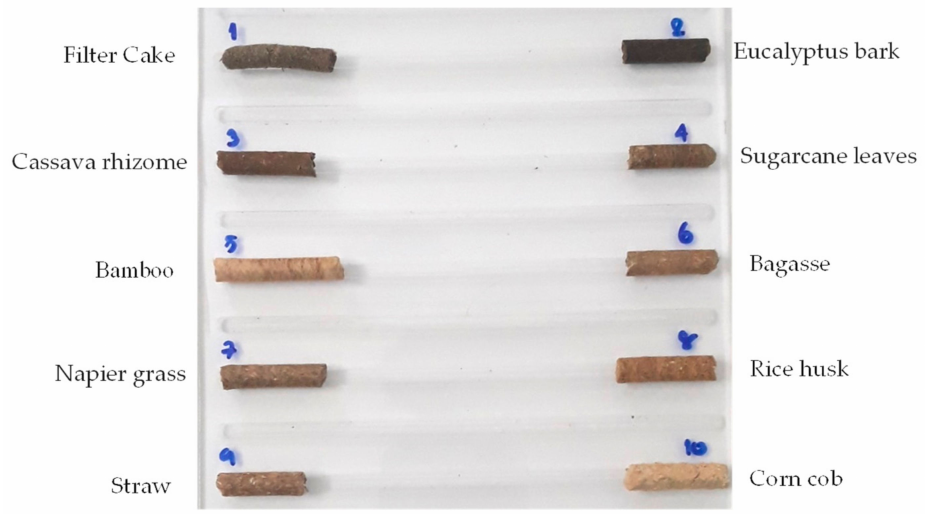
Figure 1. Biomass pellet samples placed on a sample holder.